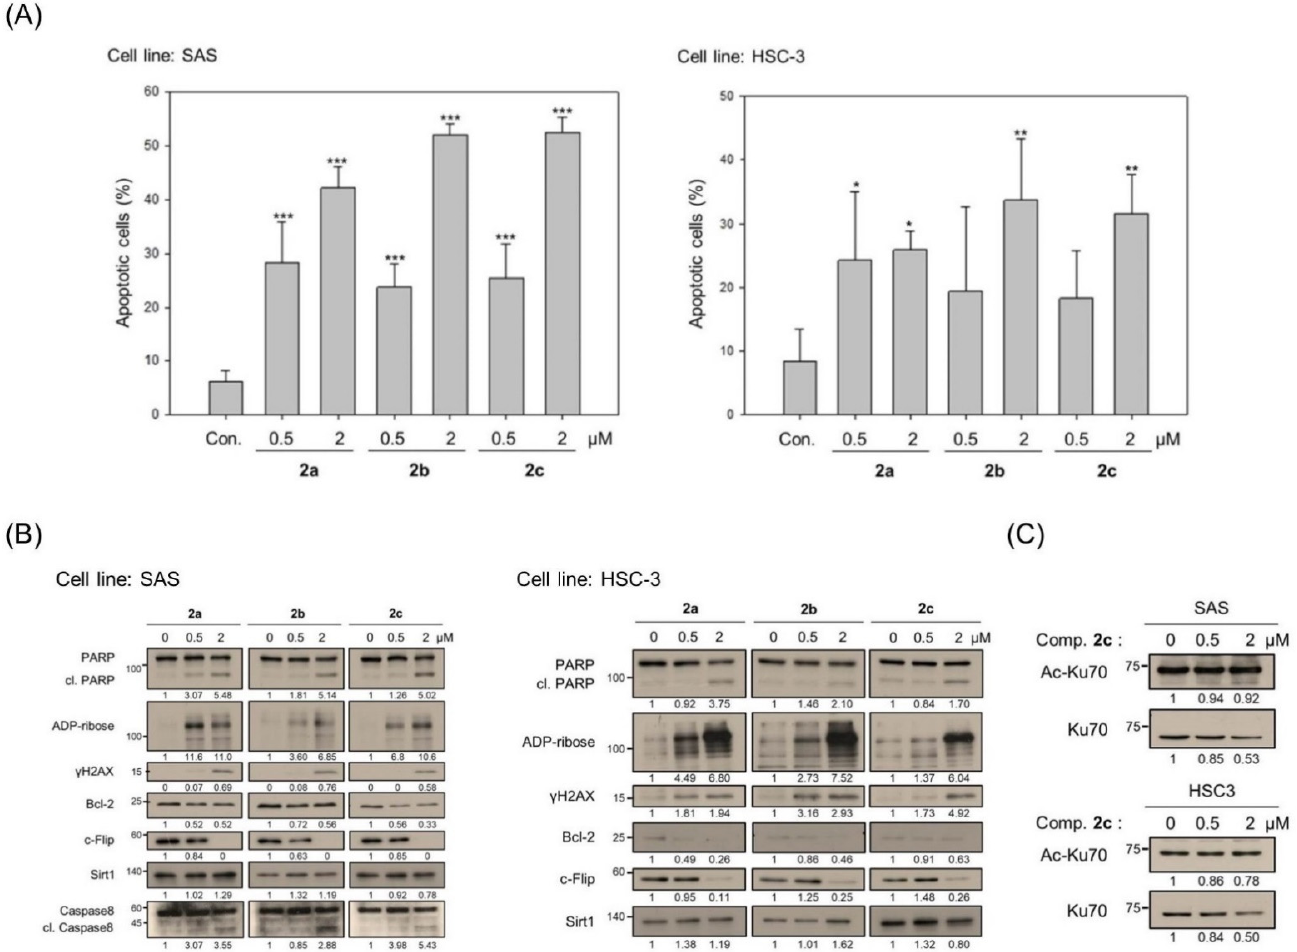
Figure 3. Bis(chloroacetamidino)heteroareneanthraquinones 2a – c provoke apoptosis in oral cancer cells. Cells were exposed to compounds at various concentrations for 24 h. ( A ) The percentage of apoptotic cells was determined by flow cytometry with Annexin V-FITC and PJ staining, and the results are presented as the percentage of apoptotic cells. Values (means ± SDs) are from at least three independent experiments (* p < 0.05, ** p < 0.01, *** p < 0.001). ( B ) Cells were treated with bis(chloroacetamidino)heteroareneanthraquinones 2a – c for various concentrations, and aliquots of cell lysates were resolved by SDS-PAGE and analyzed for protein expression by Western blotting. β -actin was used as an internal loading control to monitor for equal loading. Representative images are provided from at least three independent experiments. ( C ) Cells were treated with the derivative 2c for various concentrations, and aliquots of cell lysates were resolved by SDS-PAGE and analyzed for protein expression by Western blotting. β -actin was used as an internal loading control to monitor for equal loading. Representative images are provided from at least three independent experiments. The uncropped blots and molecular weight markers are shown in Supplementary Figure S2.